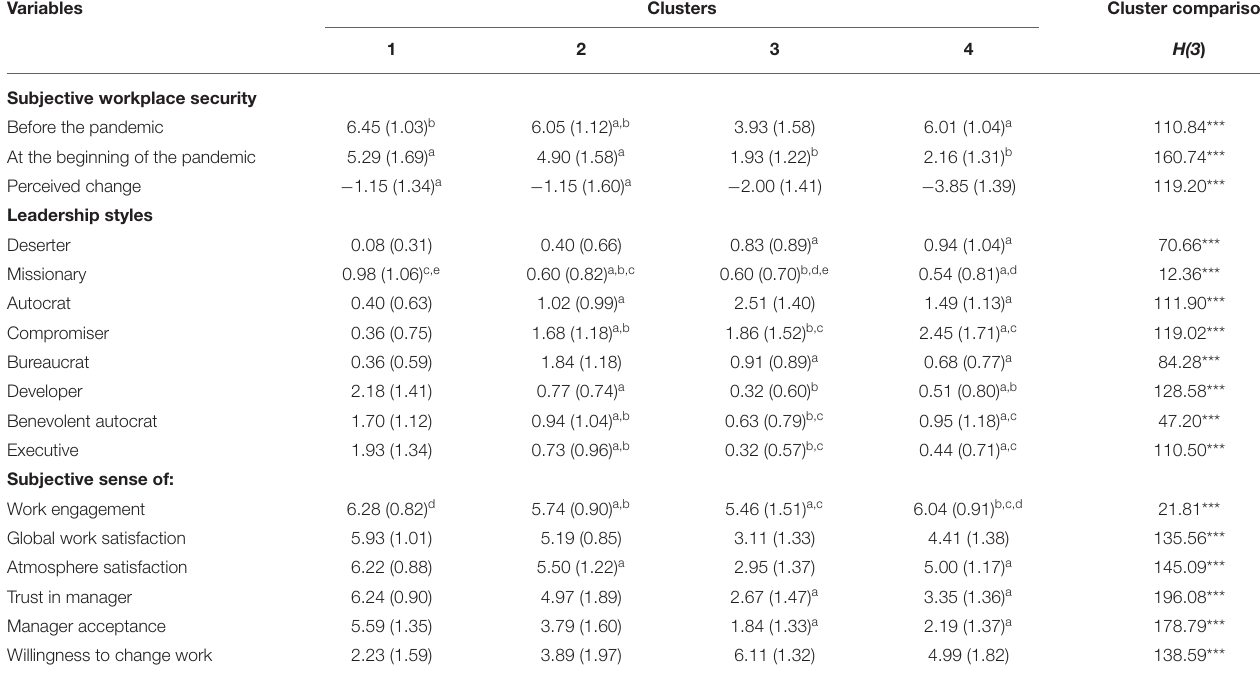
TABLE 3 | Characteristics of clusters.